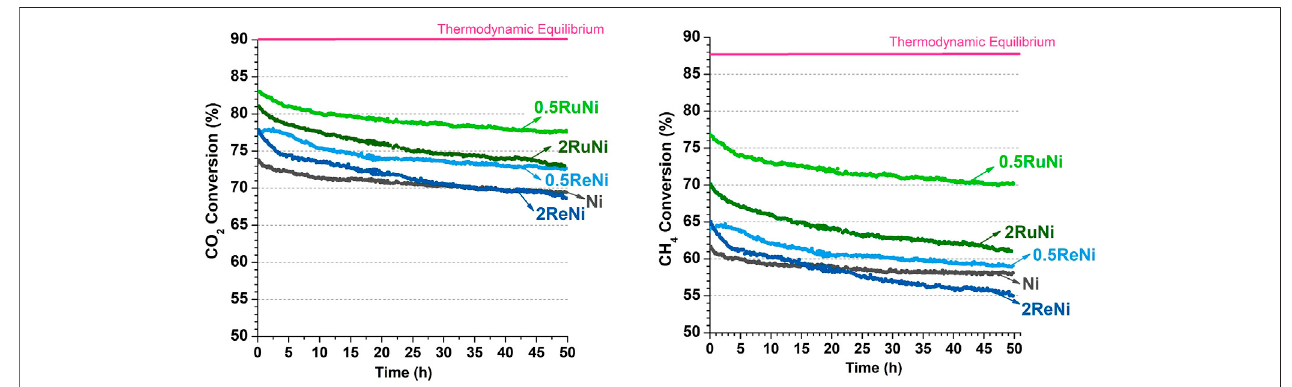
FIGURE 6 | CO 2 and CH 4 conversion in a function of time for all catalysts at 750 ° C and a space velocity of 110 L h − 1 g − 1 .